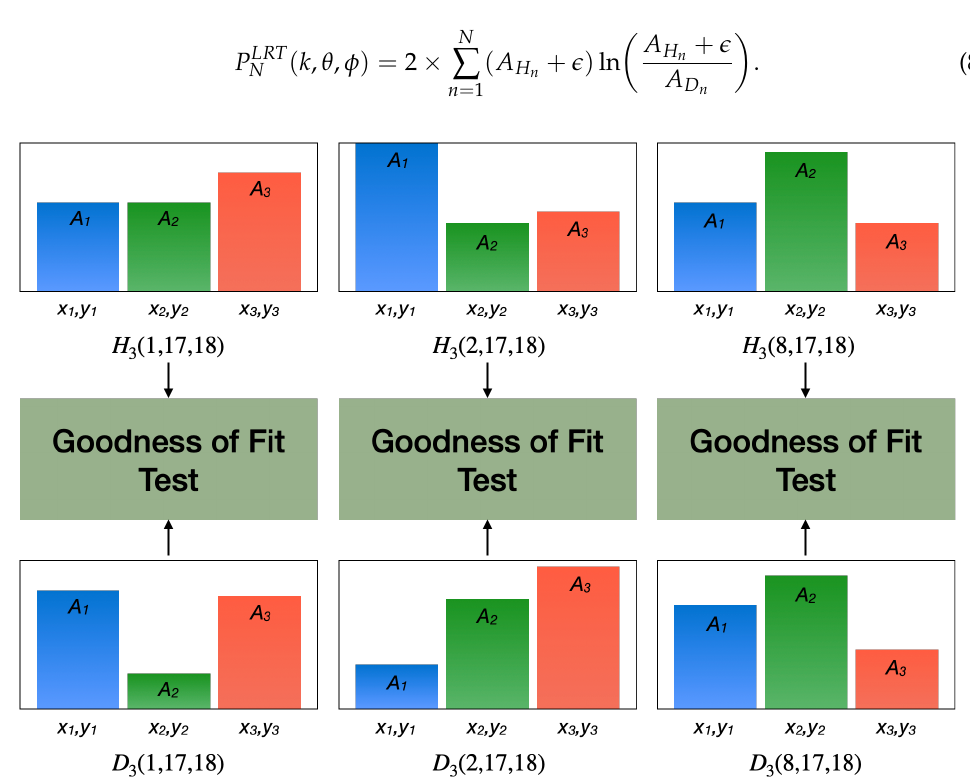
Figure 12. Illustrated example of hypothesis verification where the test target (T-72 class) is confronted against three hypotheses (BMP-2, BTR-70, and T-72 classes). A constant (cid:101) was added to A H to prevent the computation of an undefined n